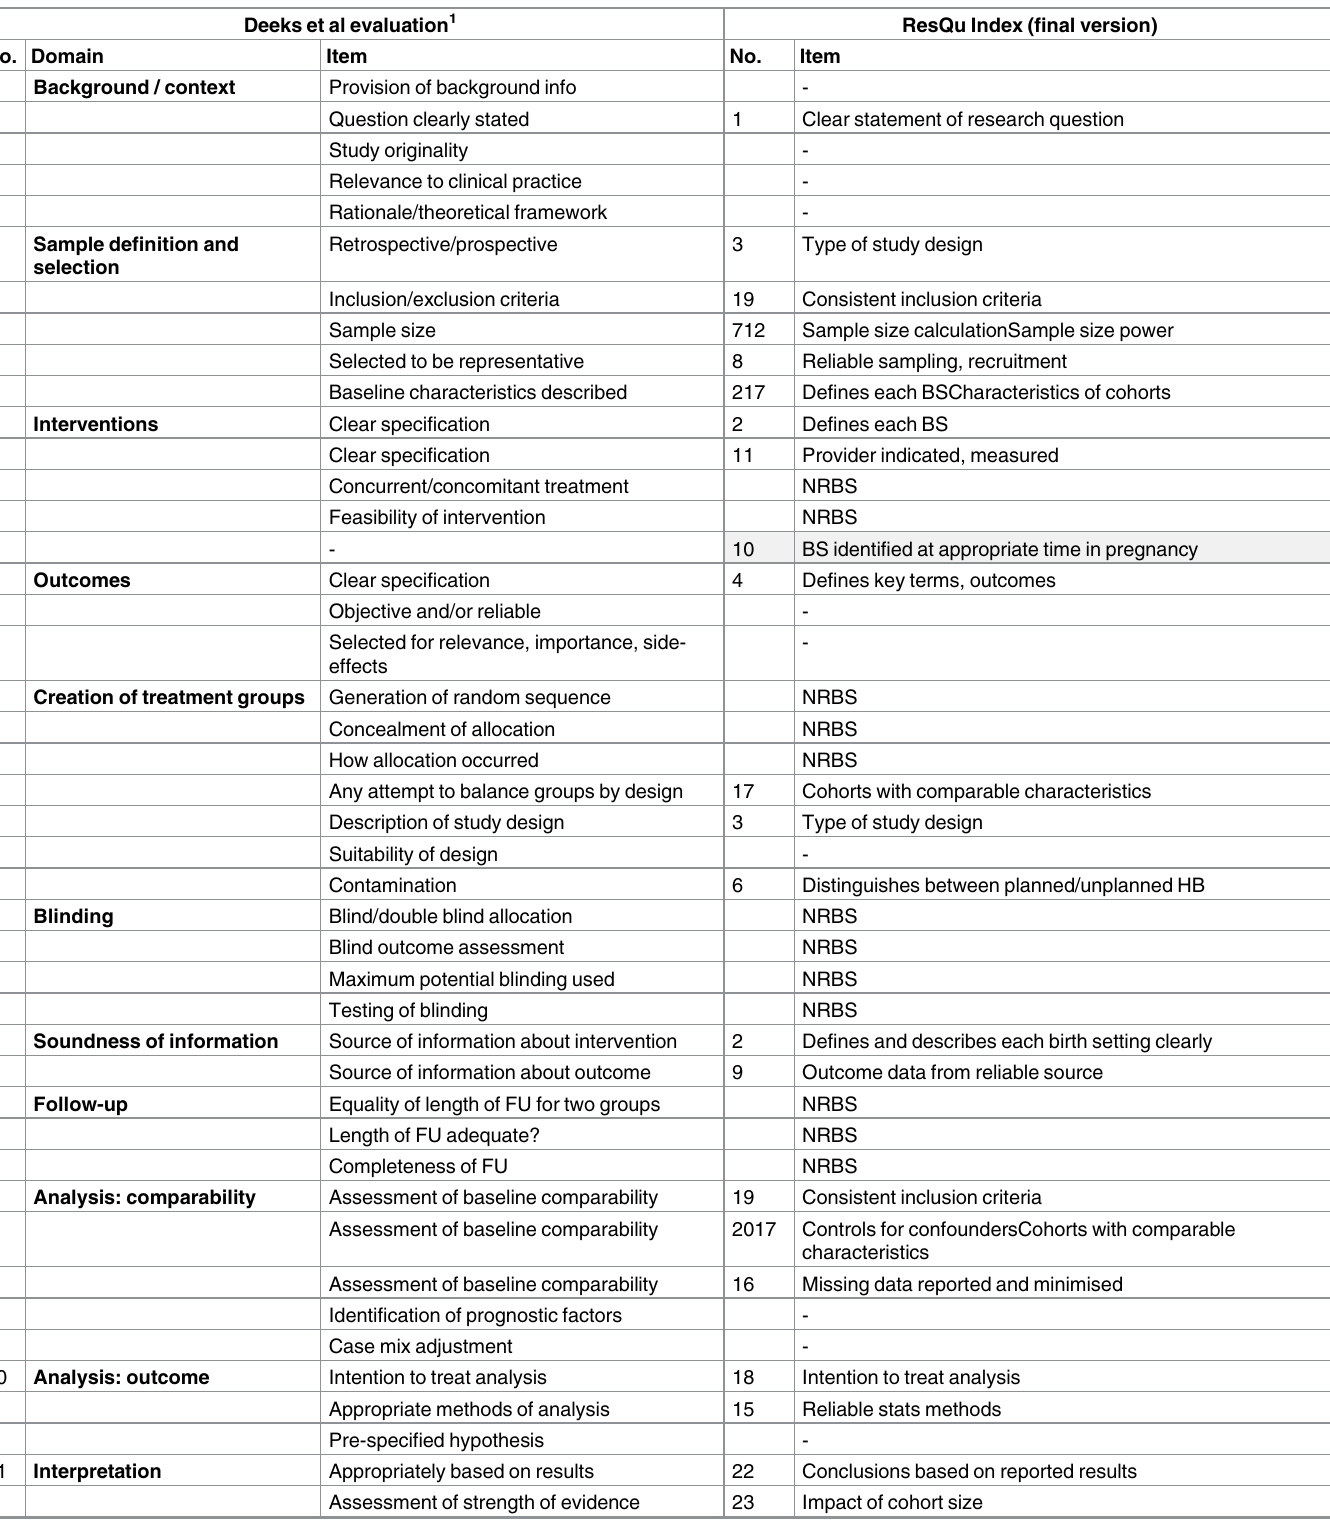
Table 4. Comparison of ResQu Items with domains of study